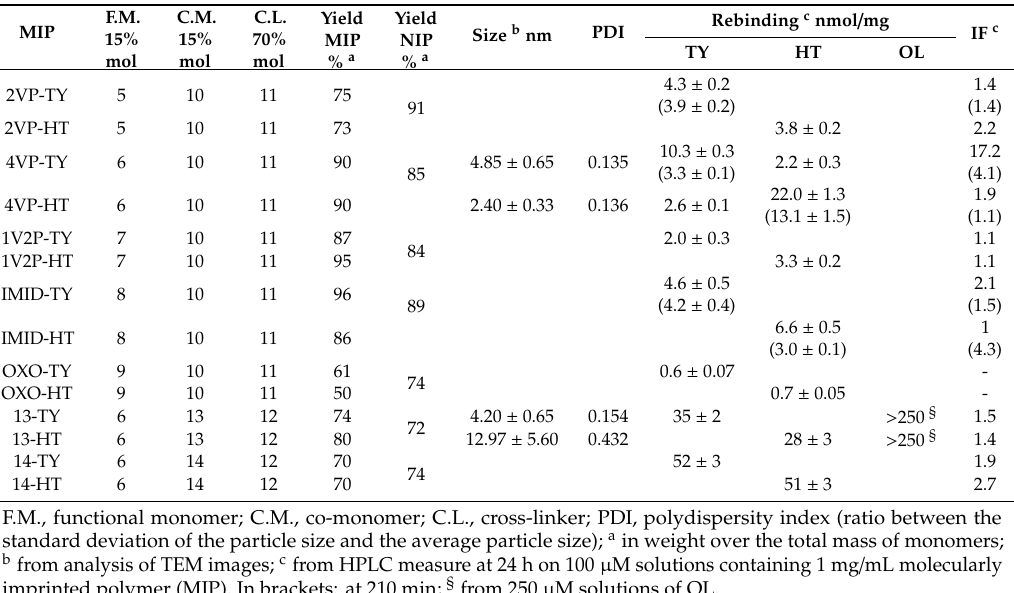
Table 2. Characterization of the imprinted materials.